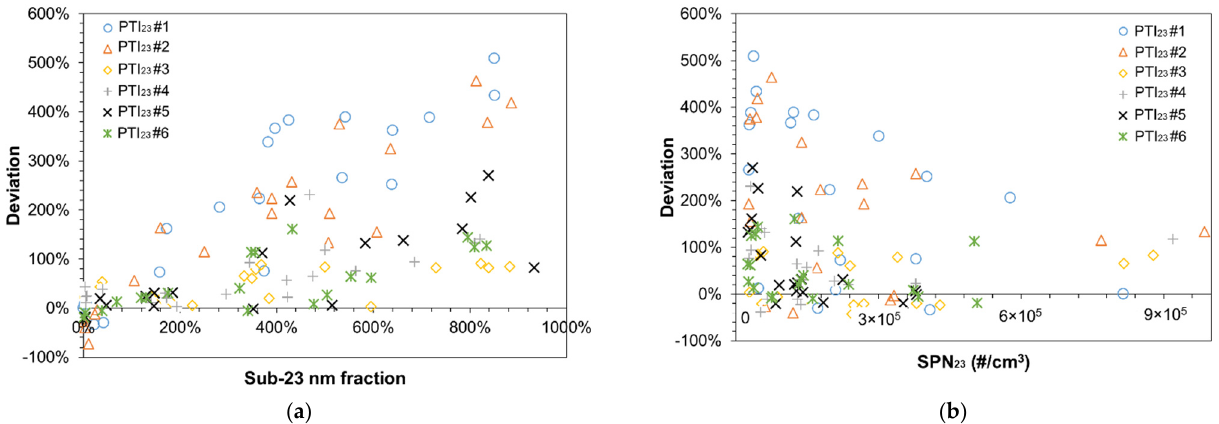
Figure 6. Summary of the deviation of the PTI sensors plotted against: ( a ) the sub-23 nm fraction (SPN 10 –SPN 23 ) / SPN 23 ); ( b ) the solid particle number of particles down to 23 nm (SPN 23 ).